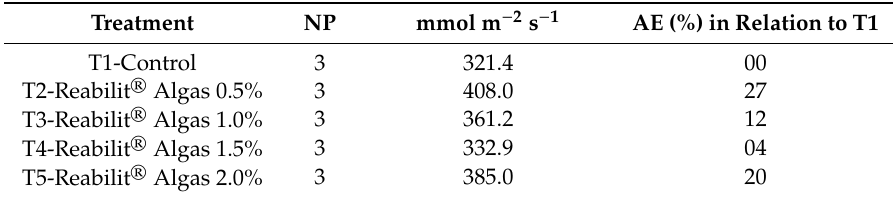
Table 2. Values for number of plants (NP), stomatal conductance (SC) and agronomic e ffi ciency (AE), in relation to control T1, performed in phenological stage: physiological maturation of pepper plants, at 12